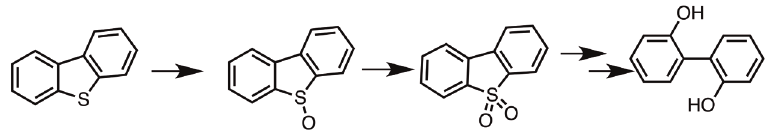
Figure 29 - Microbial desulfurization of